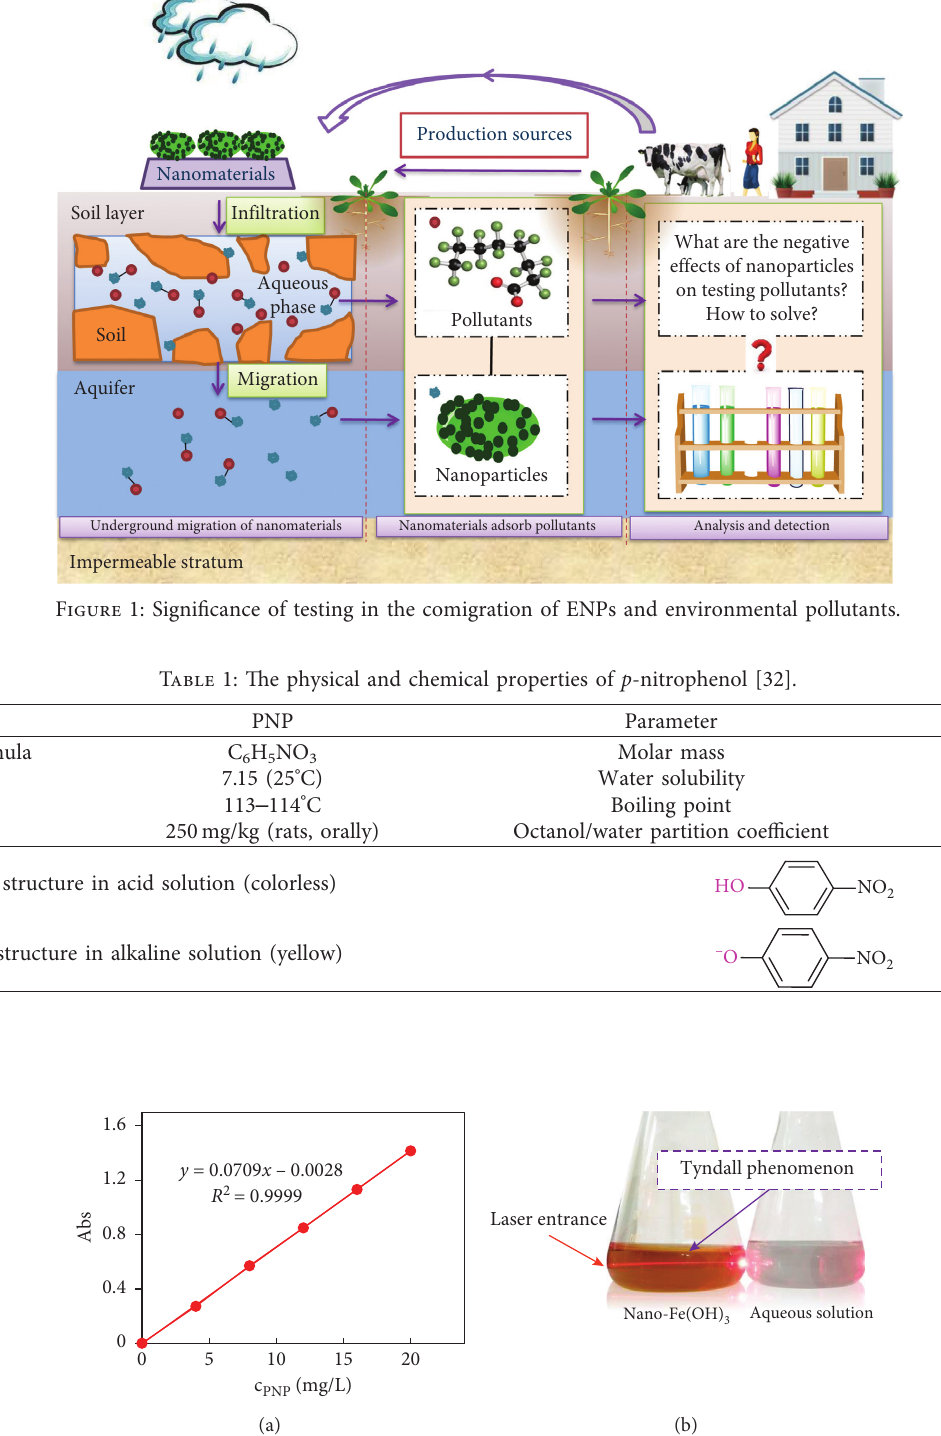
Figure 2: (a) PNP standard curve. (b) Tyndall phenomenon of the nano-Fe(OH)